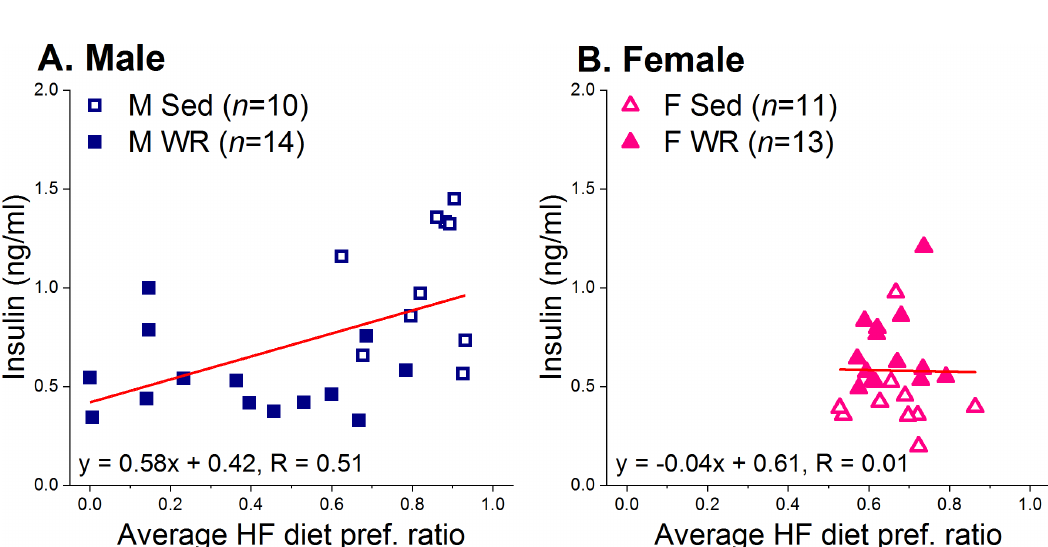
Figure 7. Correlation between trunk plasma insulin levels at the end of the experiment and the average ratios of HF diet preference. ( A ) There was a moderate, positive correlation between HF diet preference and trunk plasma insulin in males. ( B ) There was no relationship between HF diet preference and trunk plasma insulin levels in